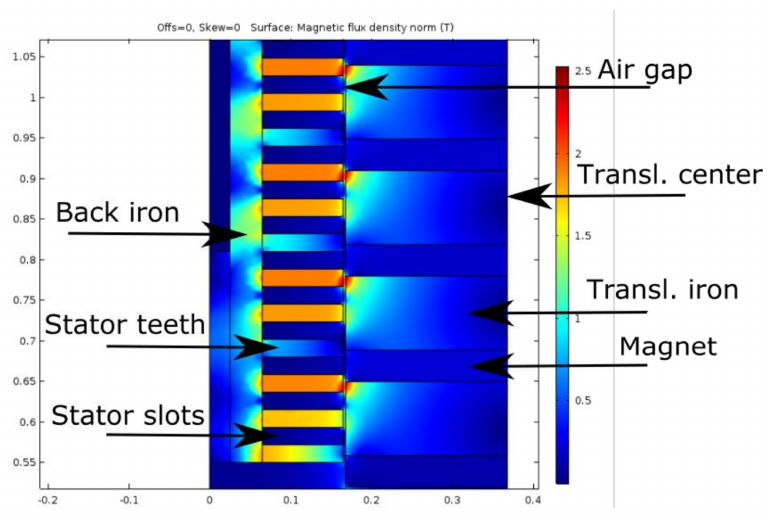
Figure 9. The magnetic flux density modulus for the example generator at 2.5 A.